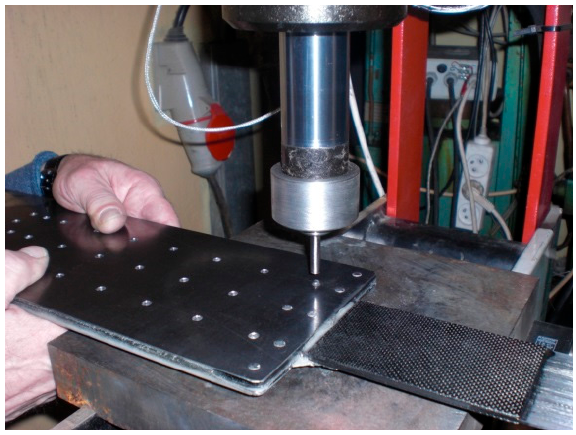
Figure 9. Rivet upsetting using the hydraulic press.